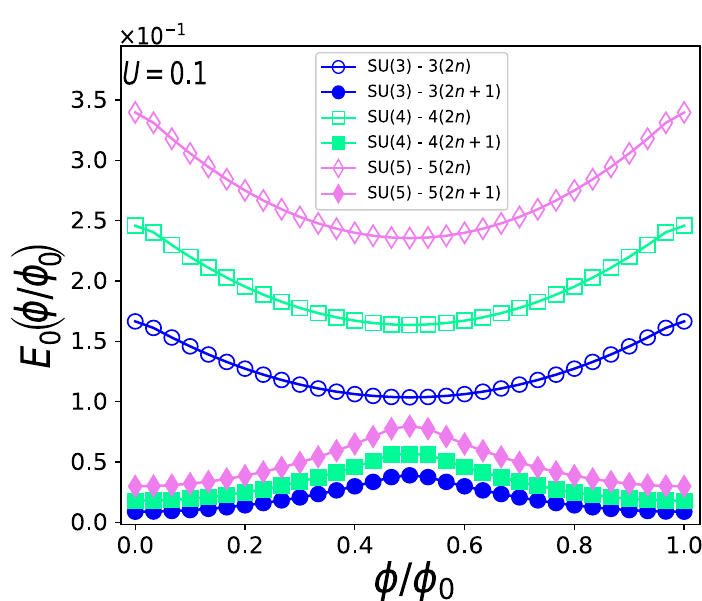
( φ ) is plotted Figure 10: Parity effect for SU( N ) fermions. Ground state energy E 0 against the flux φ for different N ranging from 3 (circles) to 5 (diamonds). Since the energy is suppressed (increased) by the effective magnetic field, systems with even (odd) number of particle per spin component are paramagnetic (diamagnetic). All the presented results are obtained by Bethe ansatz of Gaudin-Yang-Sutherland model for L = 30, with N taken to be 1 particle and 2 particles per species for each p N corresponding to n = 0,1